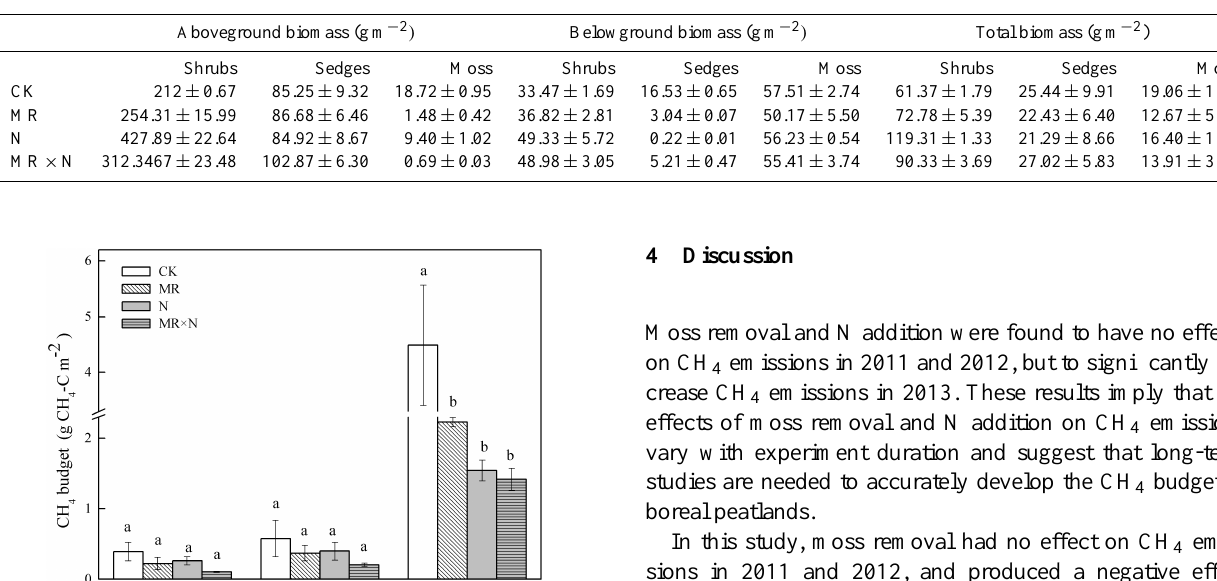
Table 3. Effects of N addition and moss removal on aboveground, belowground biomass and total biomass.